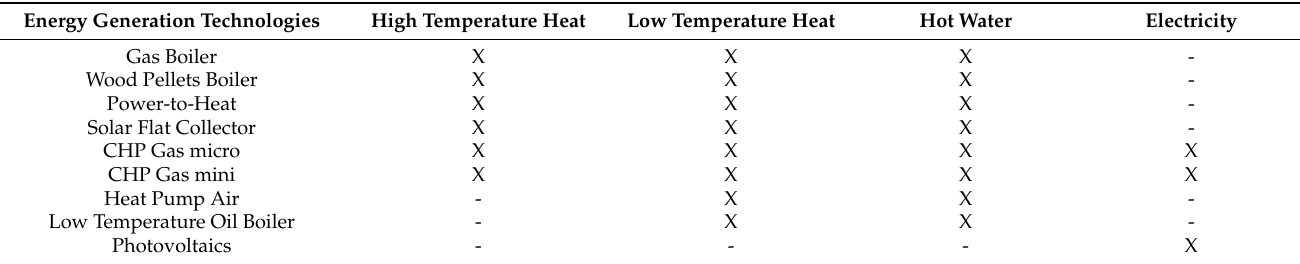
Table 2. Energy generation technologies and provided energy type and temperature levels. Energy Generation Technologies High Temperature